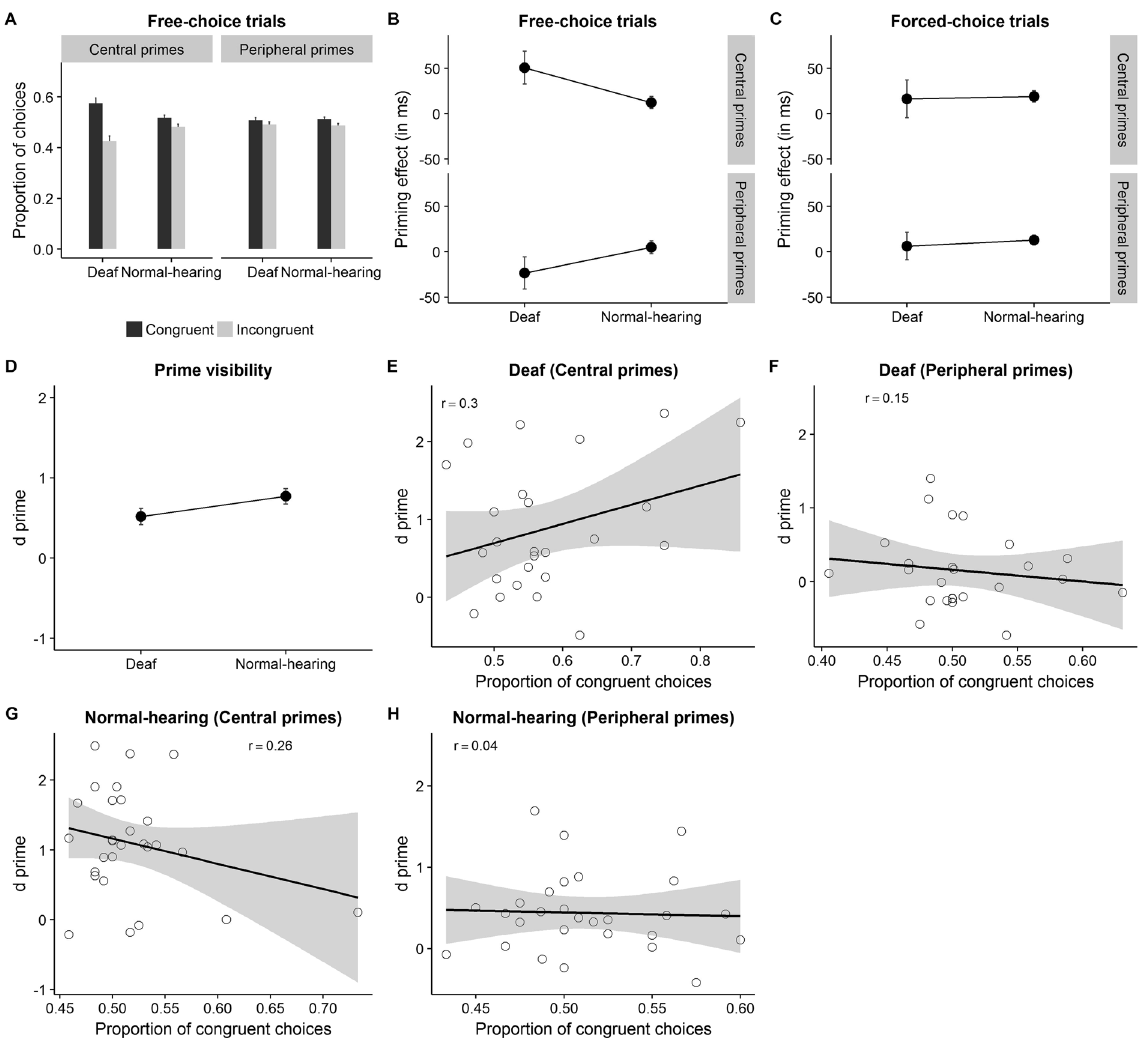
Figure 3. Experiment 2 results. ( A ) Proportion of congruent choices is higher for Deaf compared to normal- hearing, only for central primes. ( B ) Group difference on priming effect on free-choice trials, only for central primes ( C ) No group difference in priming effect on forced-choice trials ( D ) Marginally significant group difference in prime visibility index ( E , F ) Correlation plots between proportion of congruent choices and d prime. None of the correlations were